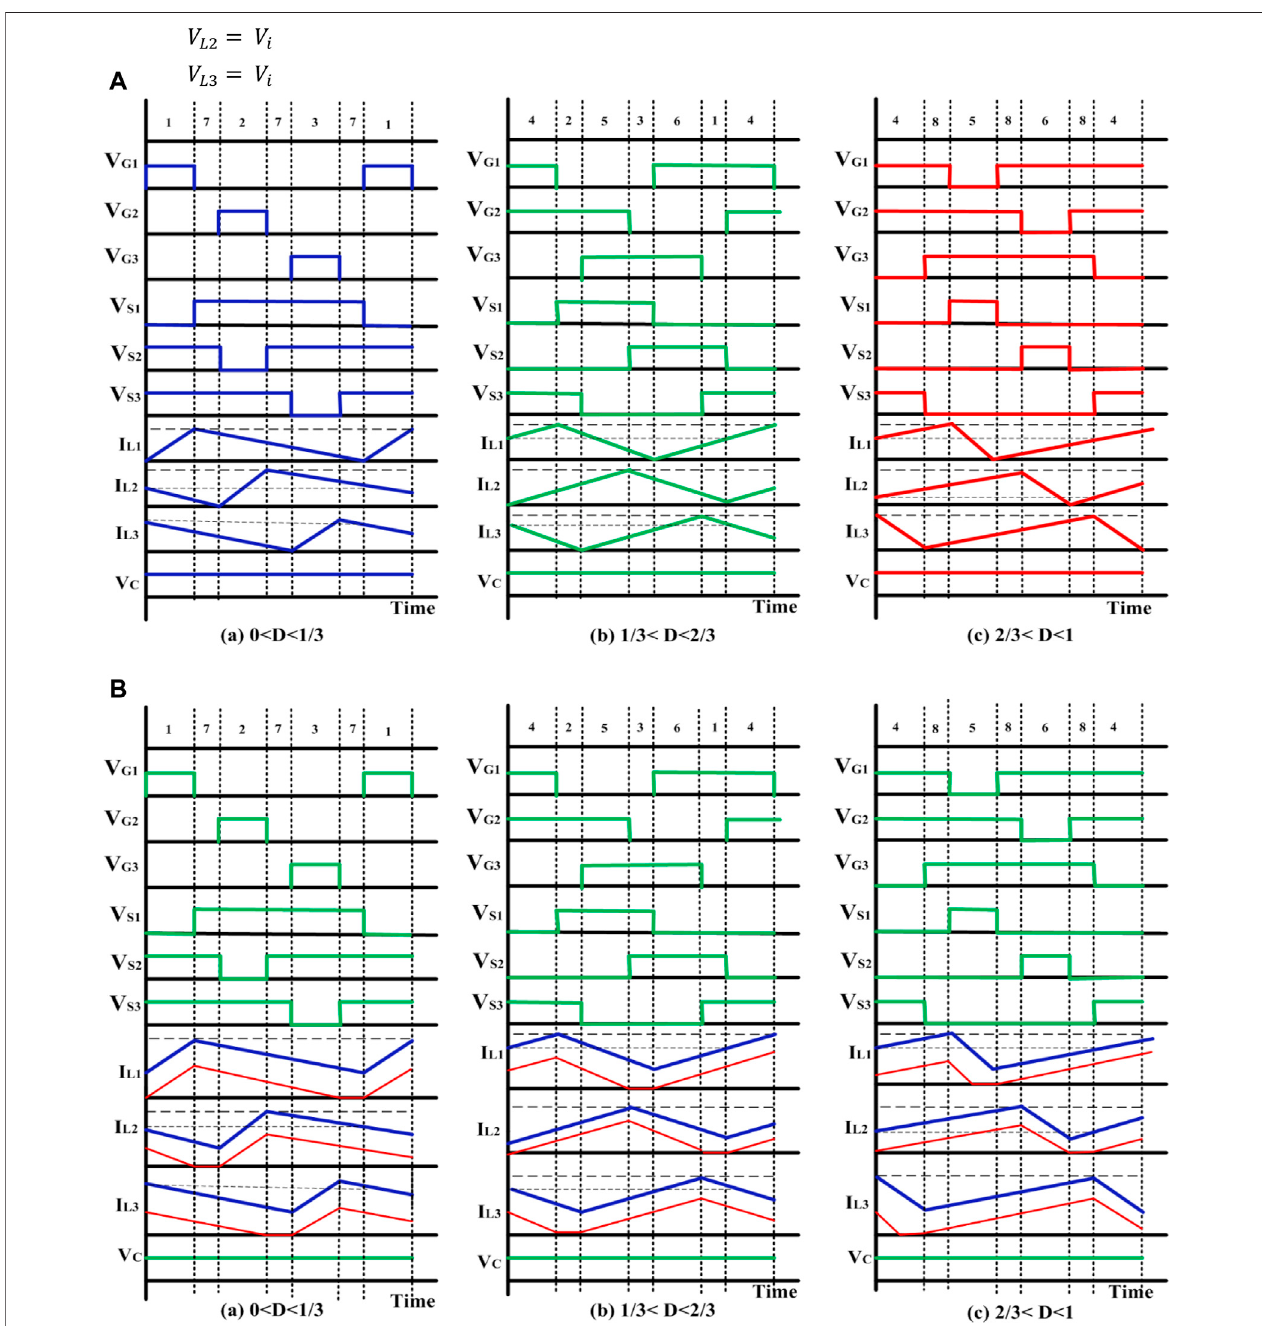
FIGURE 4 | Characteristics waveforms (A) BCM (B) CCM (blue line) and DCM (red Line).